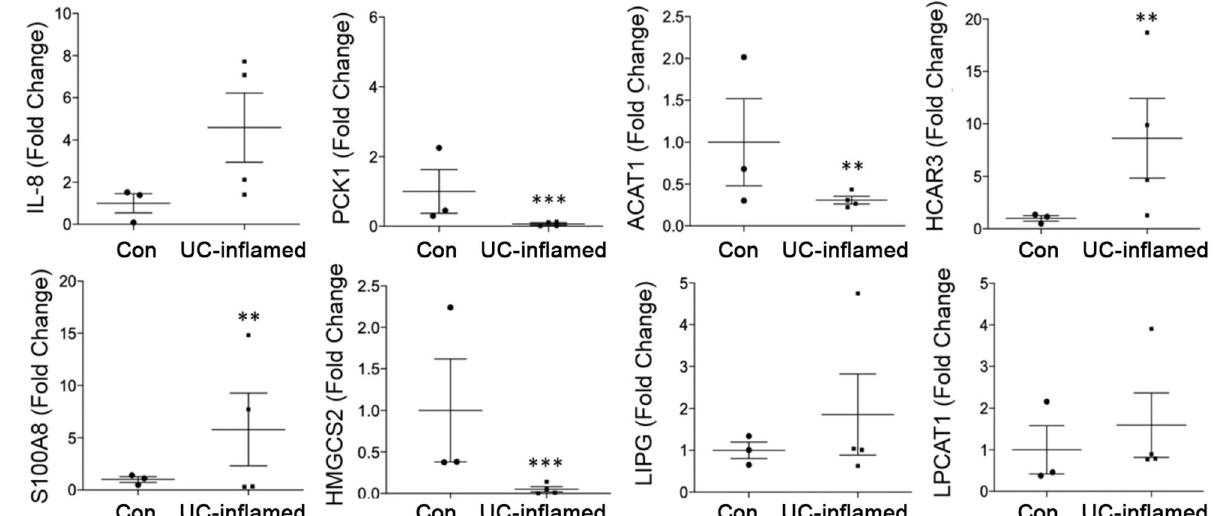
Figure 3. Altered expression of UC 100 transcripts in UC tissue. Altered levels of select, transcripts from the